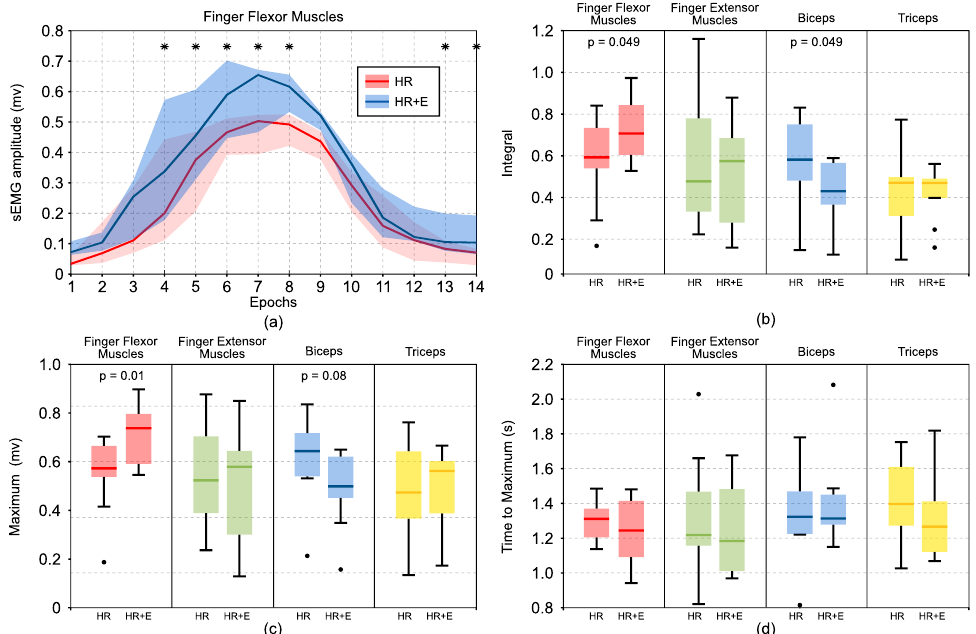
Figure 4. Graphical representation of the sEMG results. ( a ) Evolution of mean sEMG value during each condition. Shaded areas contains all of the mean values of all participants. Asterisk indicate a significant difference between conditions in that epoch. ( b ) Box plots comparison of the integral of the sEMG signal of each muscle in every condition.( c ) Box plots comparison maximum sEMG activity of each muscle in every condition. ( d ) Box plots comparison of the time to maximum sEMG activity of each muscle in every condition. Outliers are shown as black